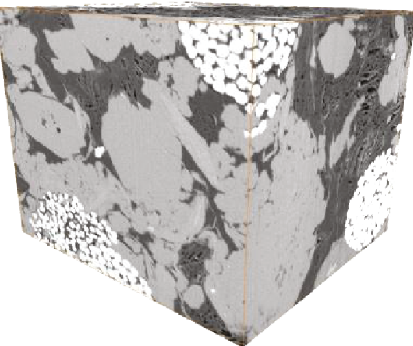
Figure 2: The multicomponent 3D digital core reconstructed by the FIB-SEM method. Di ff erent components are re fl ected in di ff erent greyscales. The 3D digital core obtained by this method has a high resolution, but the disadvantage is that the scanned sample will be destroyed.